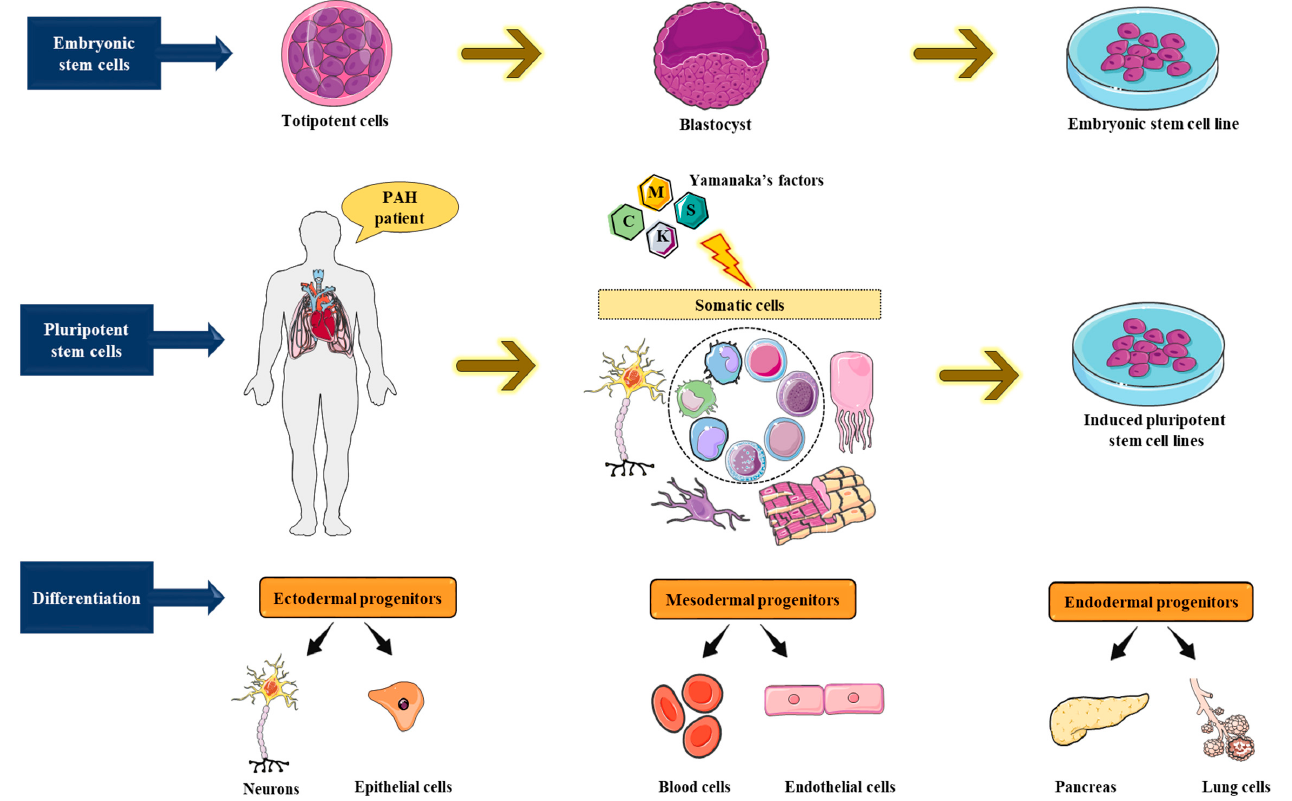
Figure 7. The unlimited potential of pluripotent stem cells in disease modeling. Embryonic stem cells (ESCs) and induced pluripotent stem cells (iPSCs) can perpetually self ‐ renew and differentiate into multiple cell forms or schemes of the three embryonic germ layers viz., the ectoderm, mesoderm, and endoderm. The ESCs are derivatives of the inner cell mass of blastocyst stage embryos, while iPSCs are derived by means of nuclear reprogramming of somatic cells through the expression of a selected group of transcription factors, classically Oct4, Sox2, Klf4, and c ‐ Myc.